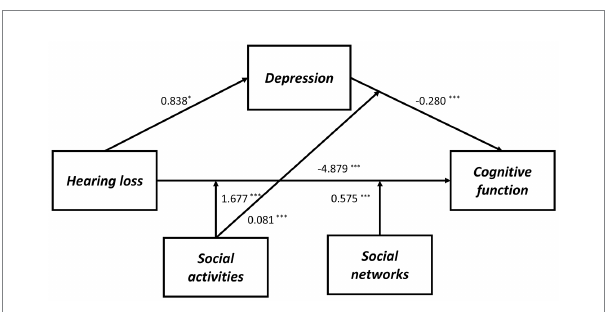
FIGURE 3 The final moderated mediation model: social activities and social networks as moderators of the mediation model of depression between hearing loss and cognitive function (Andrew Hayes’s mediation-moderation Model 76, * p < 0.05; *** p < 0.001). The moderated mediation model was controlled for covariates (age, gender, education level, marital status, lifestyle scores, ADL scores, and physical comorbidities).